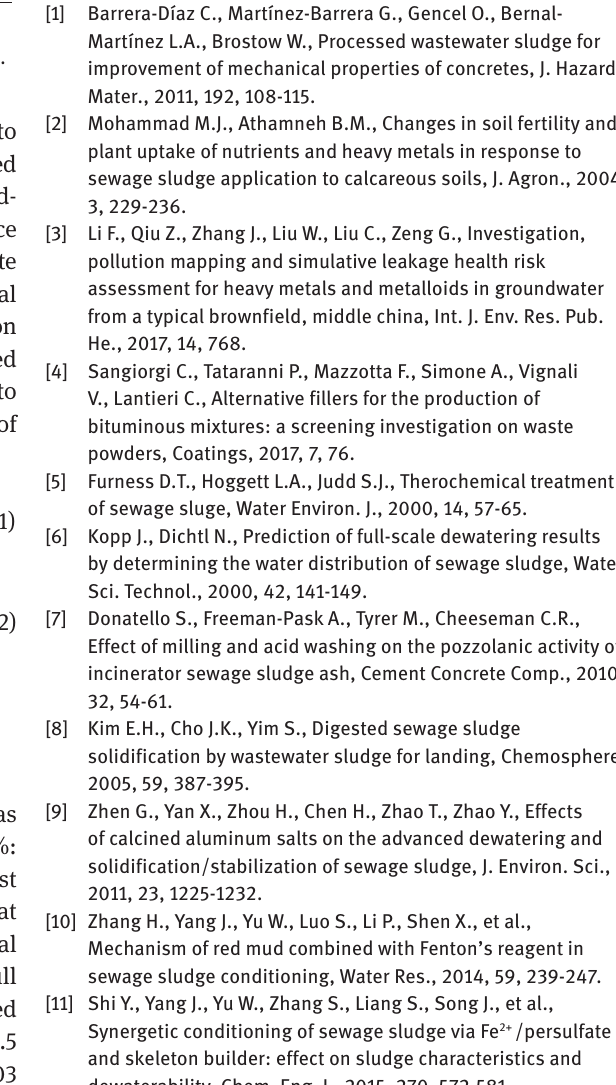
Figure 9: SEM- energy spectrum of S1 hydration products in sludge.